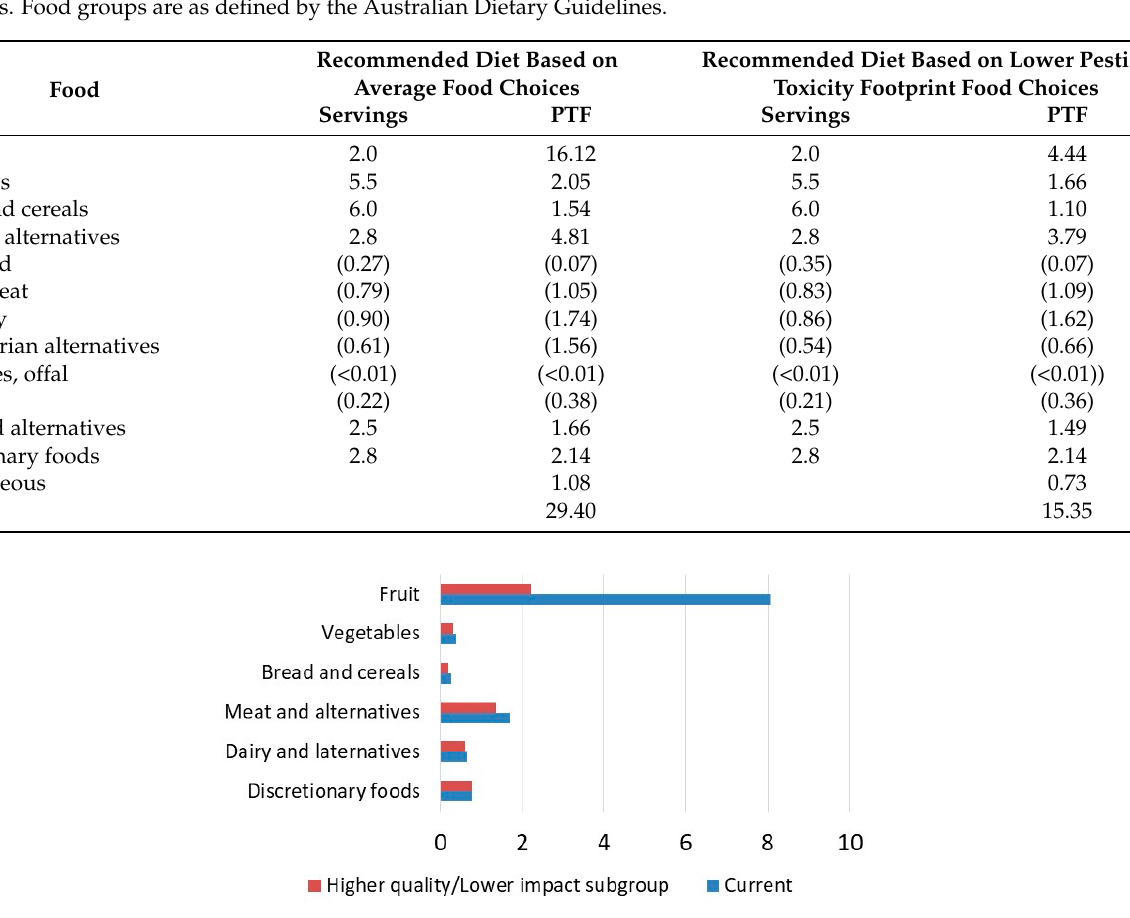
Figure 3. Pesticide toxicity footprint intensity of the major food groups (points per serving). Shown are the results for the current average 19 − 50-year-old Australian daily diet, as well as a higher diet quality and lower pesticide toxicity footprint subgroup identified by the quadrant analysis.